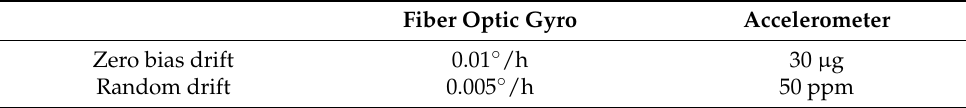
Figure 14. The diagram of experimental system composition. Table 5. Performance parameters of SINS.